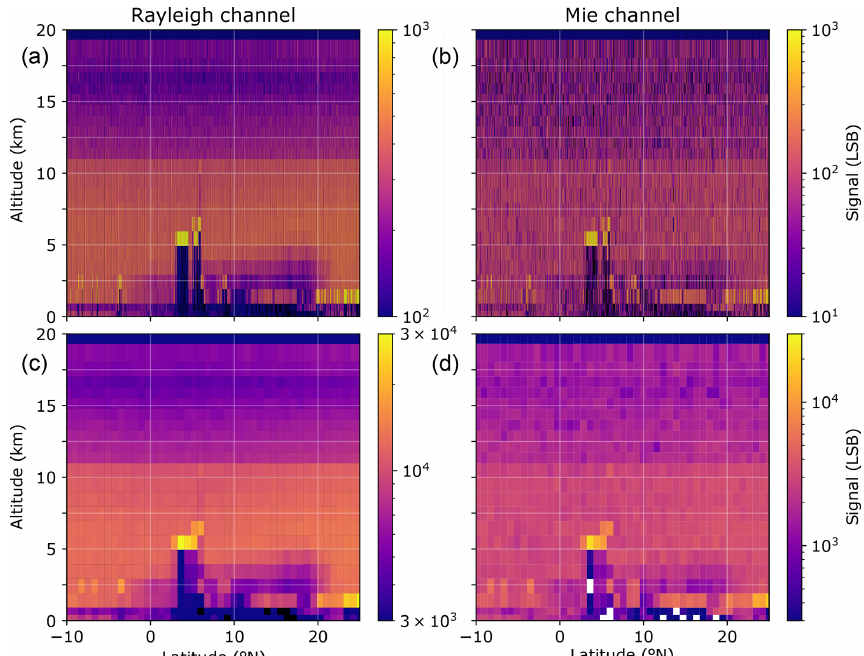
Figure 1. Example of raw, in-orbit Rayleigh and Mie “useful signals” from the L1B product in least-significant bits (LSBs) at a measurement scale of 2.9km ( a, b ) and after accumulation to an observation scale of 87km ( c, d ) showing the input to the test case that is discussed in Sect.